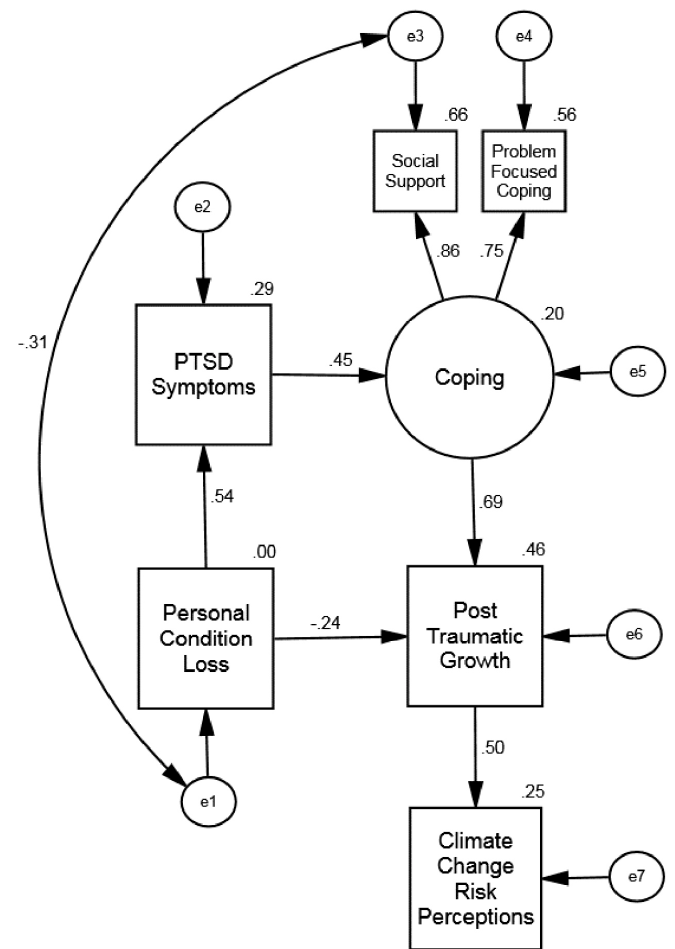
Figure 4. (Study 2, Fiji) . Confirmatory Sample Structural Equation Model: Influence of Resource Loss on Posttraumatic Symptoms, Coping, Posttraumatic Growth, and Climate Change Risk Perception. The offset values on endogenous variables are R 2 effect sizes.